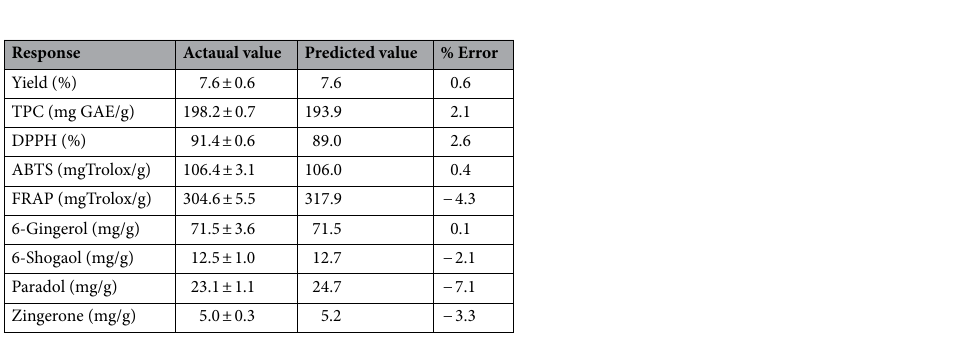
Table 3. Predicted and actual values for optimal